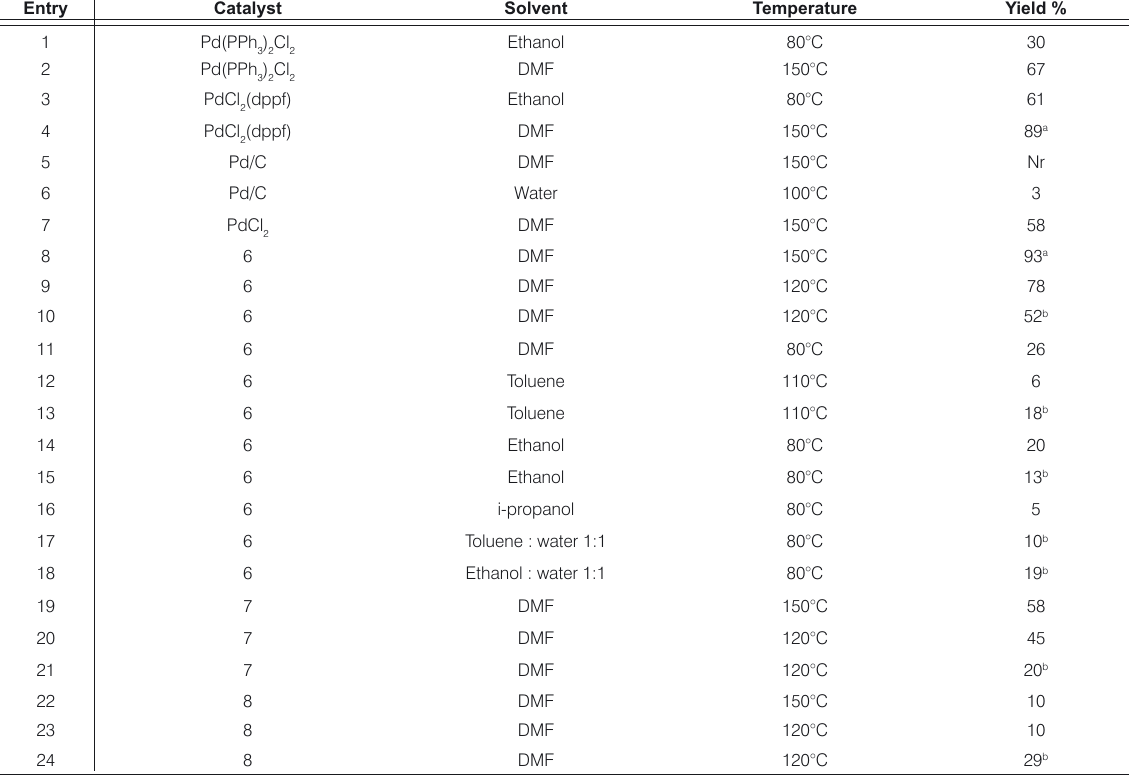
Table 1. The synthesis of Diflunisal with different